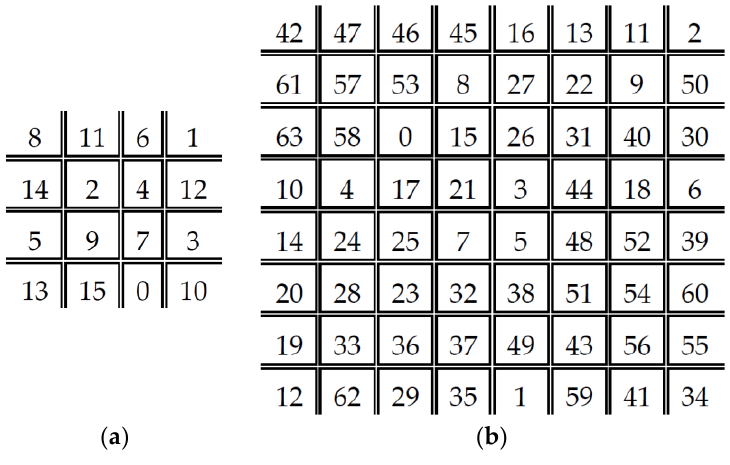
Figure 5. DDBTC class matrix for image block size: ( a ) 4 × 4 ; and ( b ) 8 × 8 .